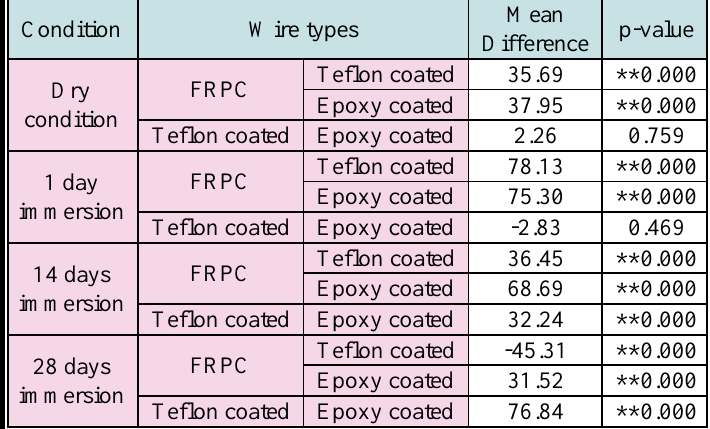
Table 2: Differences in Ra of different types of esthetic wires ateach immersion